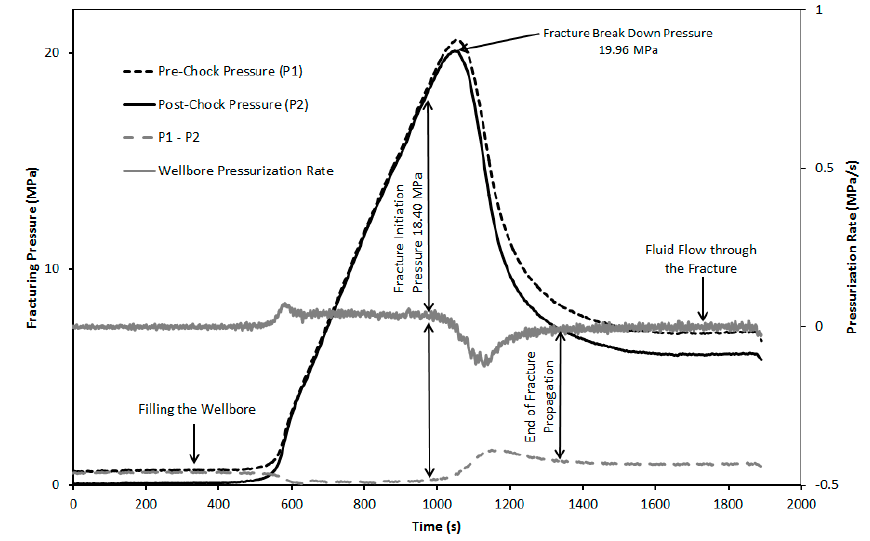
Figure 5. Fracturing pressures recording and wellbore pressurization rate for test SL-1.